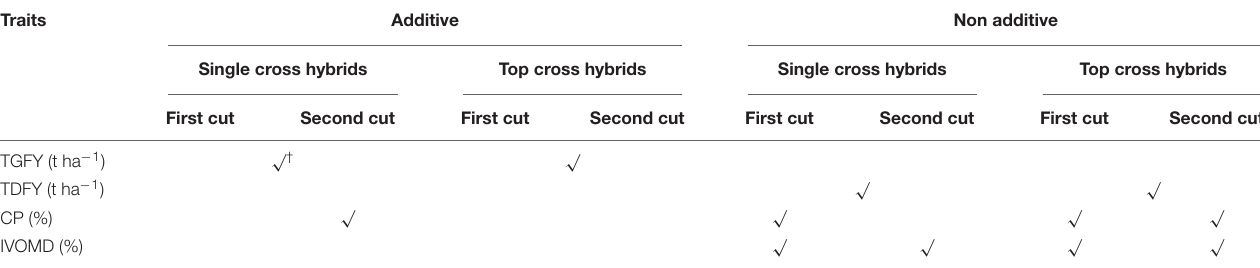
√ † indicates presence of gene action. TGFY-total green forage yield, TDFY-total dry forage yield, CP-crude protein and IVOMD-in vitro organic matter digestibility.